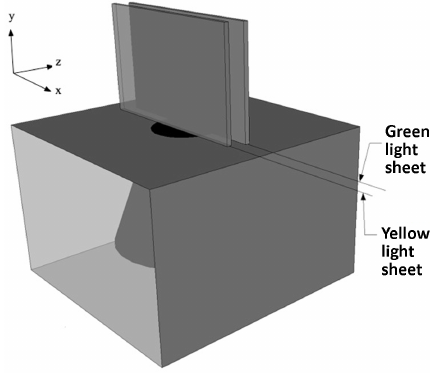
Figure 3. Schematic of the swirling jet chamber showing the orien- tation and position of the two light